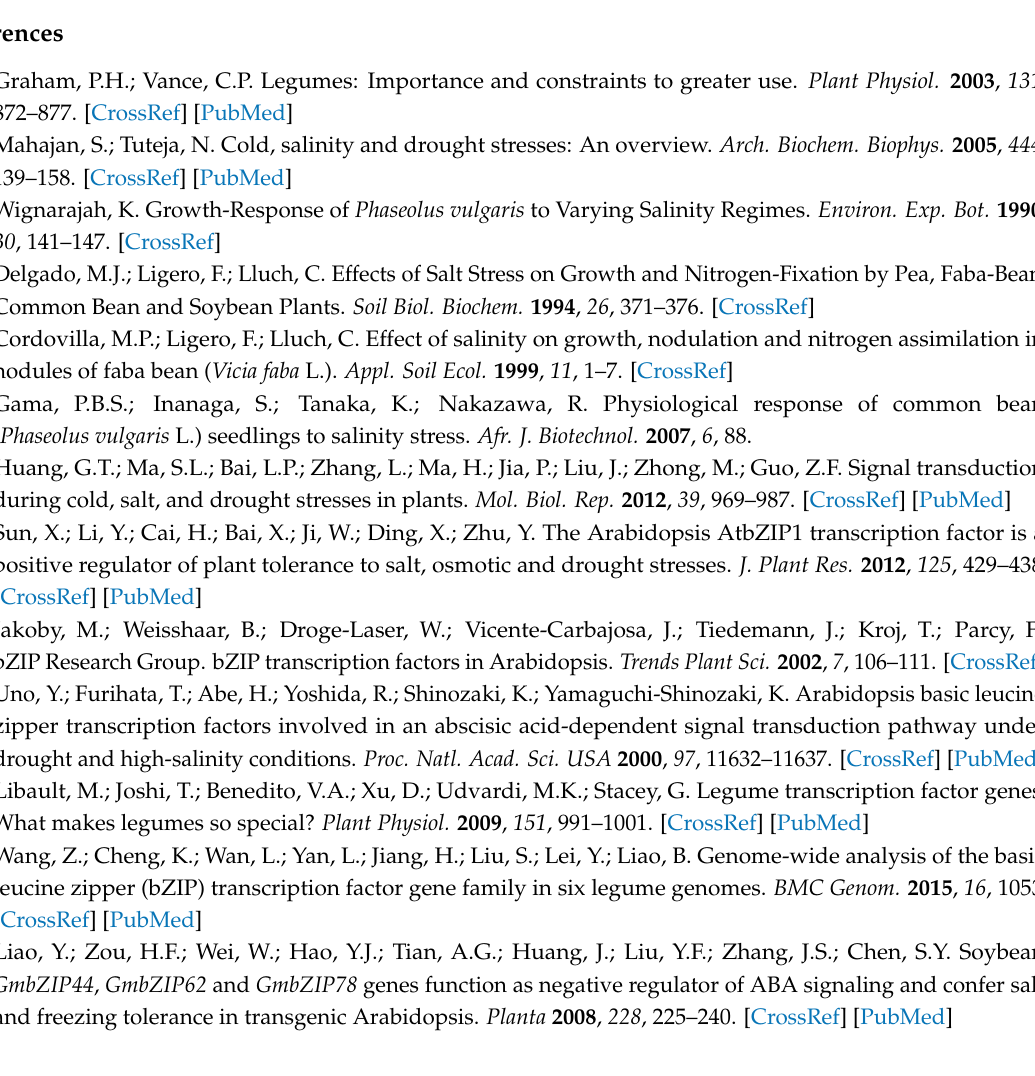
Figure S1: Level of expression of the PvbZIP genes across different tissues, Table S1: Phaselus vulgaris bZIP genes and primer sequences used for qRT-PCR expression analysis, Table S2: Expression analysis (qRT-PCR) of PvbZIP genes in roots from fertilized plants and roots and nodules from SNF plants in salinity and control